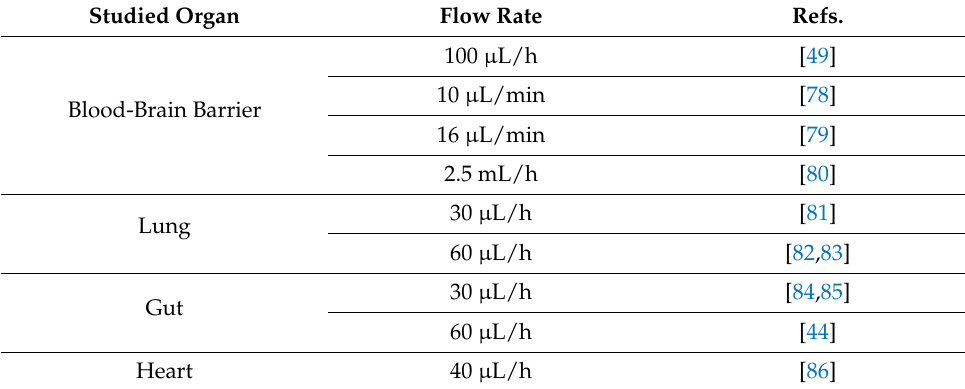
Table 1. Applied flow rates in different OOCs. Studied Organ